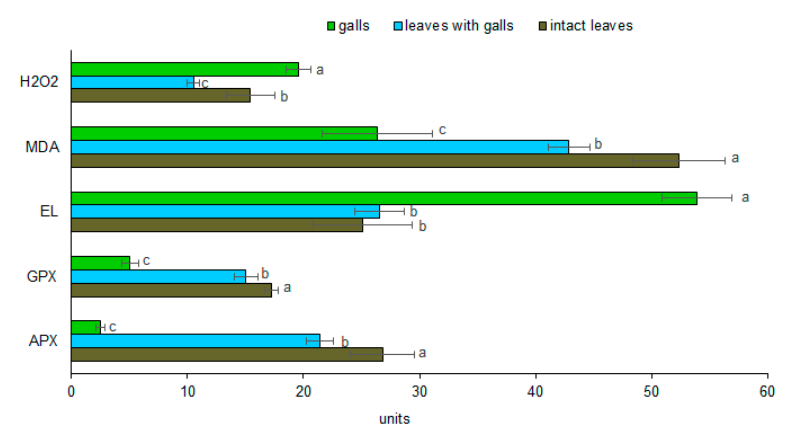
Figure 3. The effect of P. spyrothecae feeding on H 2 O 2 ( μ mol g − 1 FW) and malondialdehyde (MDA) (nmol g − 1 FW) concentrations, electrolyte leakage (E L ) (%) level, and activity of guaiacol peroxidase (GPX) (U mg − 1 FW) and ascorbate peroxidase (APX) (U mg − 1 FW) in Populus nigra “Italica” tissues (means ± SD). Bars sharing the same letter for each parameter do not differ significantly at p ≥ 0.05 (Tukey’s HSD